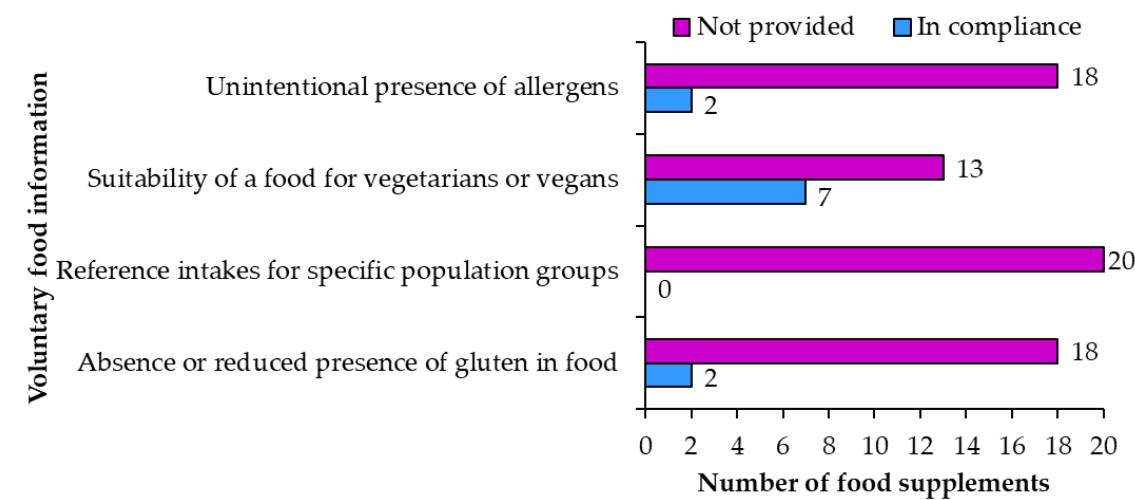
Figure 9. Voluntary food information on food supplement labels.